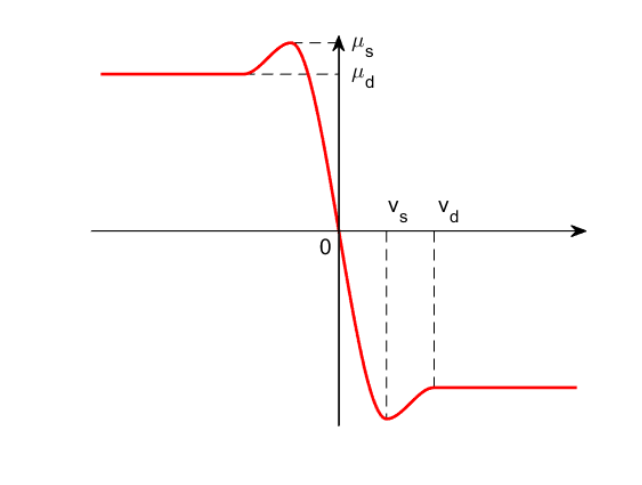
Figure 9. Coefficient of friction in velocity-based friction model. Table 1. The parameters of four test cases.